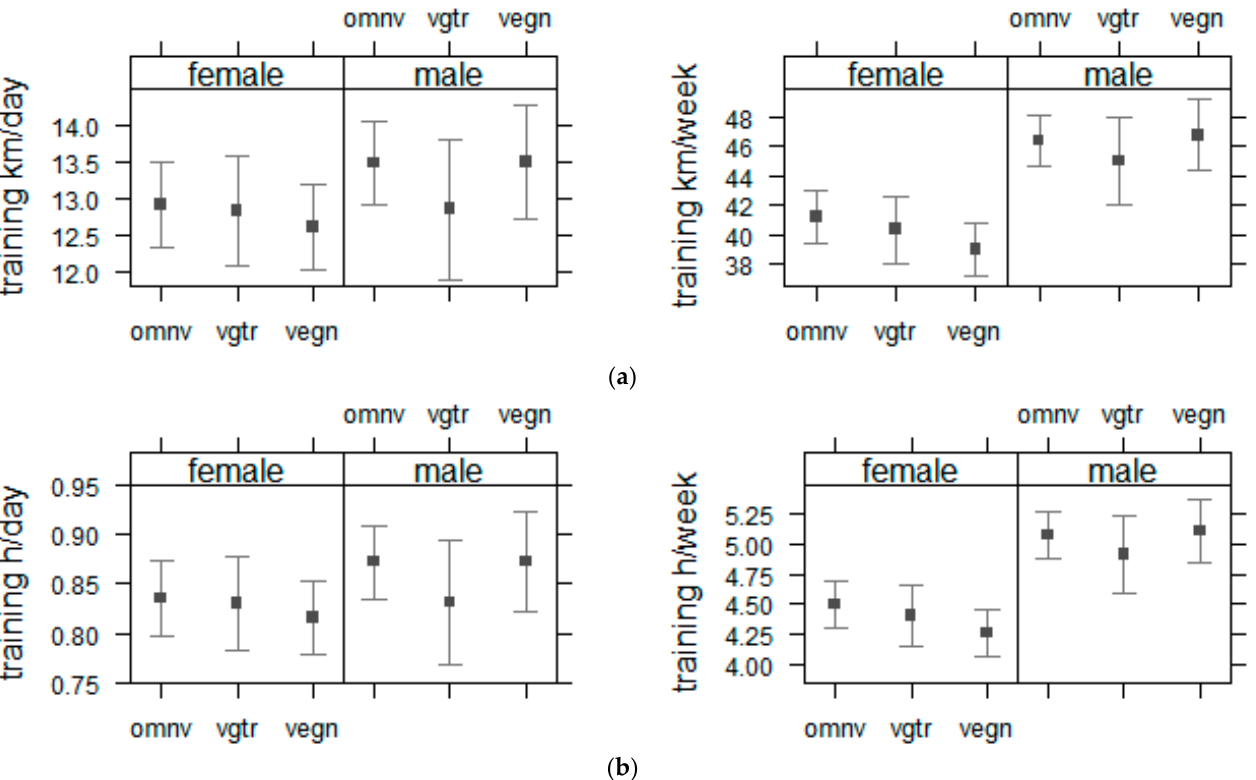
Figure 4. Mean effect size to display the interaction between diet type, sex, and weekly training mileage ( a ) or weekly training duration ( b ). Note: Results are presented as mean effect sizes with bars displaying 95%-CI with lower and upper 298